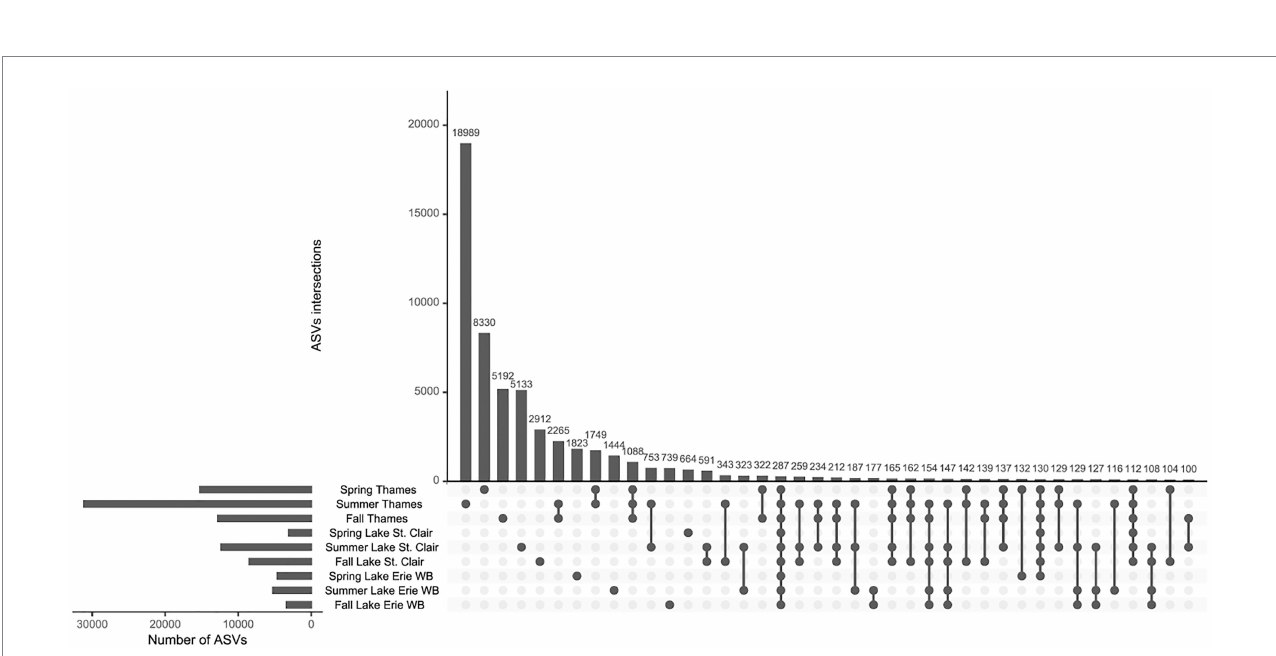
FIGURE 4 Intersection of ASVs across systems and seasons. Horizontal bars indicate the total number of ASVs for each system at each season and vertical bars represent the number of ASVs in the category designated by the dot below. Detroit River samples were lumped with Lake St. Clair samples and winter samples were removed due to lack of system represented. Only intersections of more than 100 ASVs are